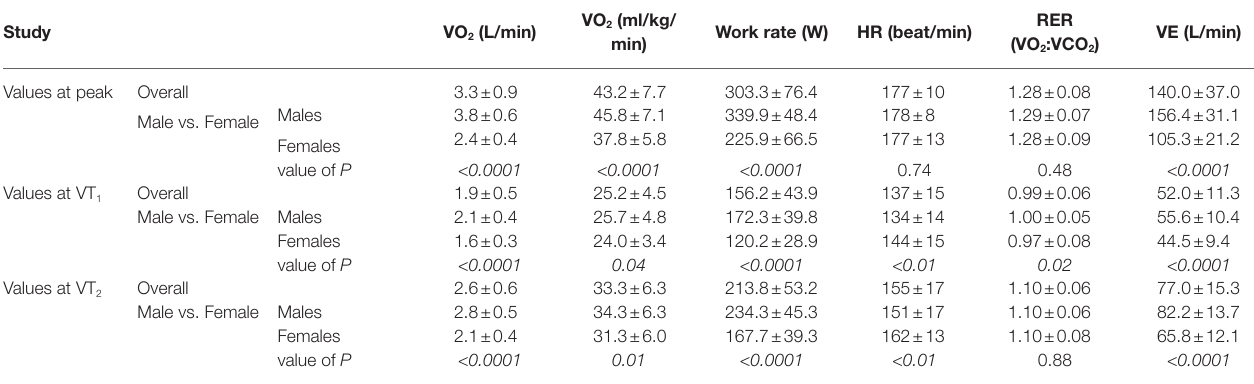
TABLE 2 | Mean values at peak, VT 1 , and VT 2 .